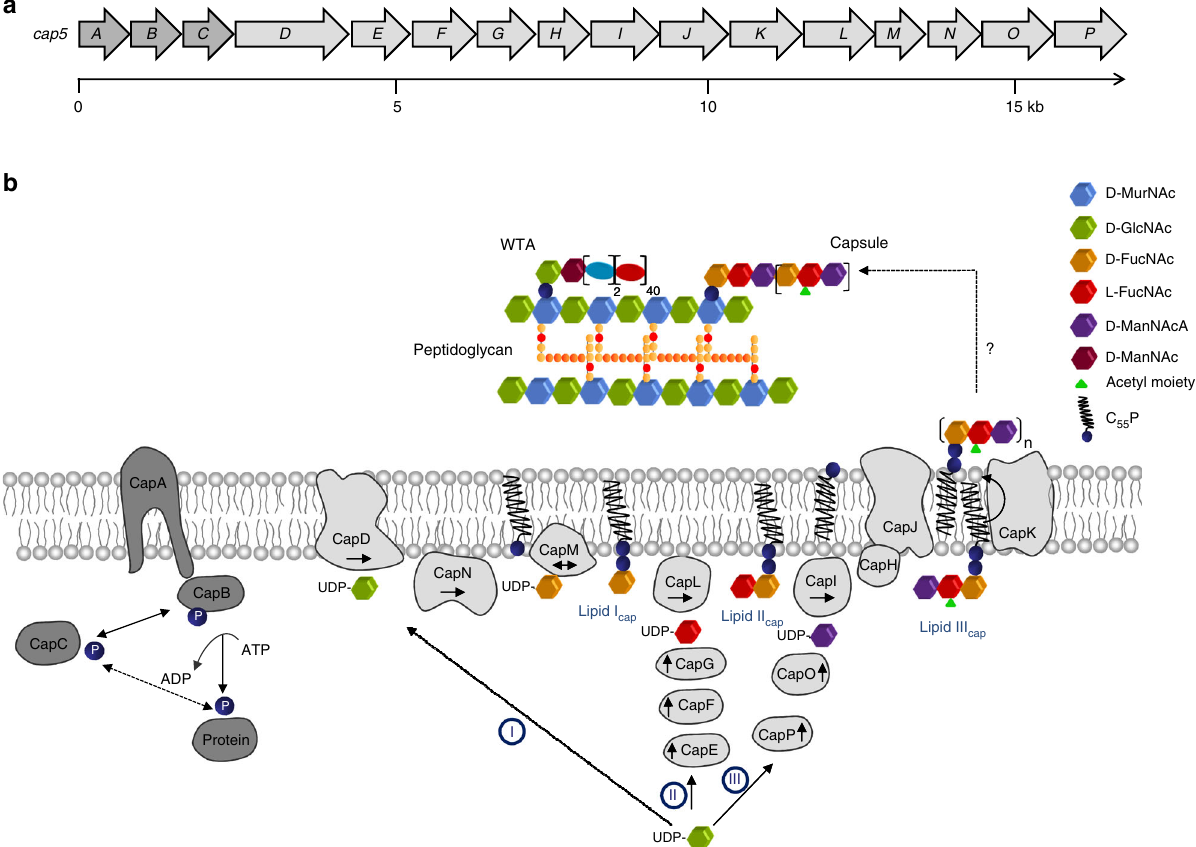
Fig. 1 S. aureus capsule biosynthesis. a S. aureus capsule (CP5) biosynthesis gene cluster (NWMN_0095 – 0110). b Model for the capsule (CP) biosynthesis pathway in S. aureus and its regulation by the tyrosine kinase complex CapA1B1. C 55 P, undecaprenyl-phosphate; GlcNAc, N -acetyl-glucosamine; FucNAc, N -acetyl-fucosamine; ManNAc, N -acetyl-mannosamine; ManNAcA, N -acetyl-mannosaminuronic acid. Arrows indicate synthesis direction. Double arrow indicates reaction